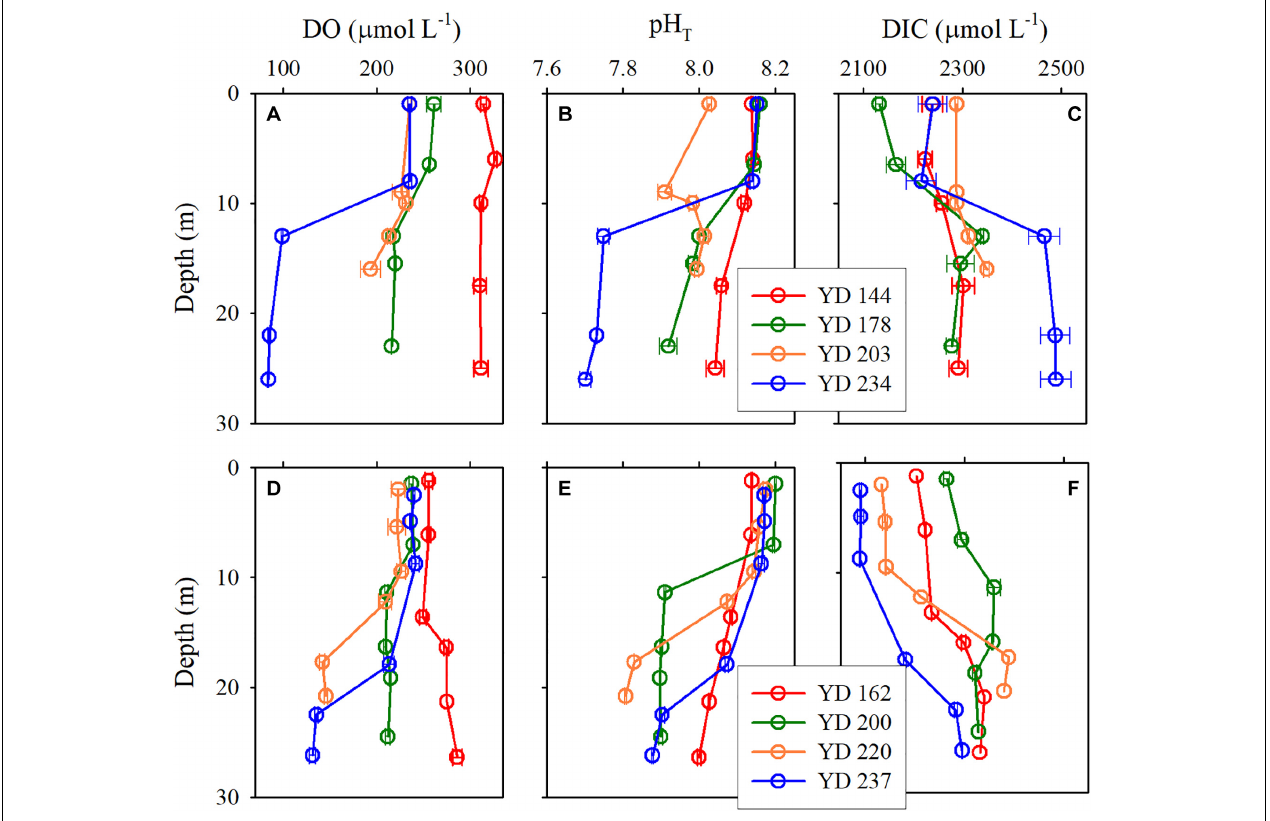
FIGURE 3 | Vertical profiles of DO (A,D) , pHT (B,E) , and DIC (C,F) for each cruise at station A5 in 2017 (upper panels) and 2018 (lower panels).